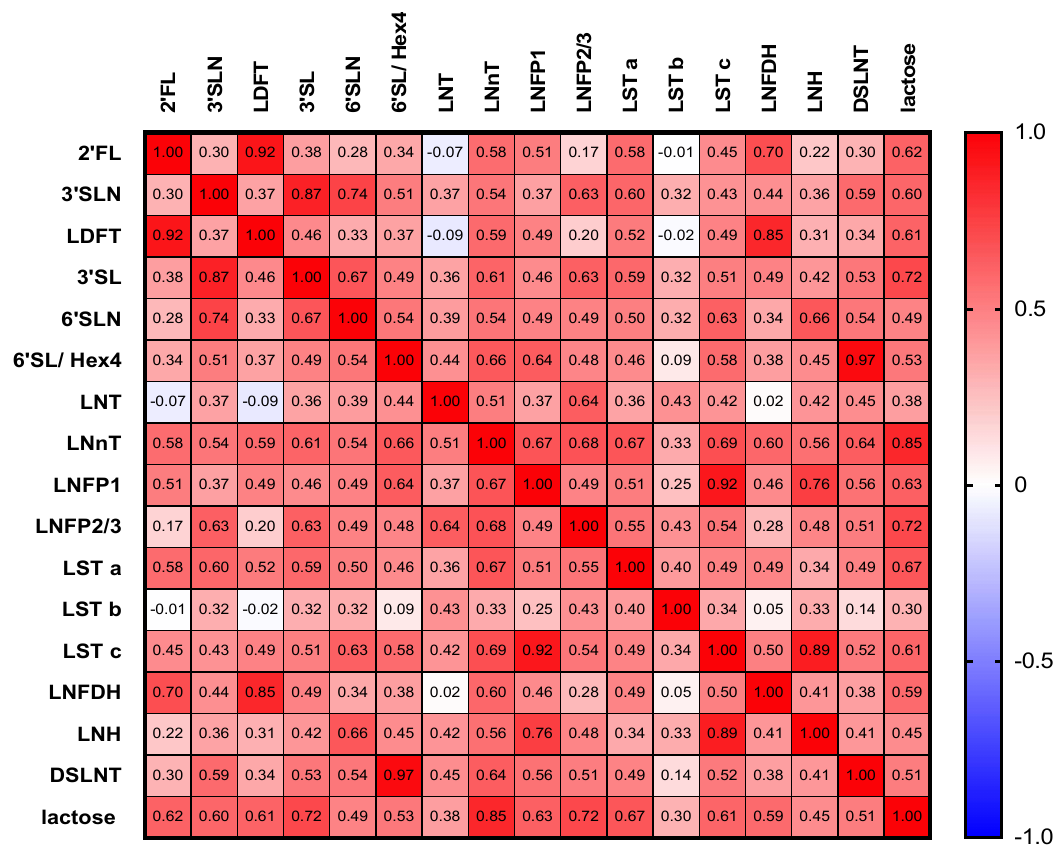
Figure 3. Intercorrelation of HMOs with each other across all sampling periods. The correlation matrix shows Spearman correlations (positive correlations in red, negative correlations in blue) of individual HMOs with each other. All correlations with Spearman coefficient r > 0.17 were significant or highly significant.